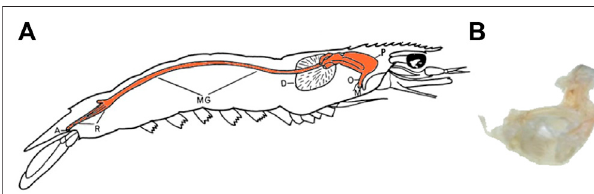
FIGURE1| Prawnanatomy. (A) thedigestive tractdiagramofapenaeid prawn,adaptedfromDall(1968),theorangeshadedareaisthedigestivetract being preserved in all samples (A — anus, D — digestive gland or hepatopancreas, M — mouth, MG — midgut, O — oesophagus, P — proventriculusorforegut,R — rectum). (B) theremaininggutliningoftheN. norvegicus after the application of the digestion protocol using potassium hydroxide (KOH) at 40 ° C (Hara et al.,